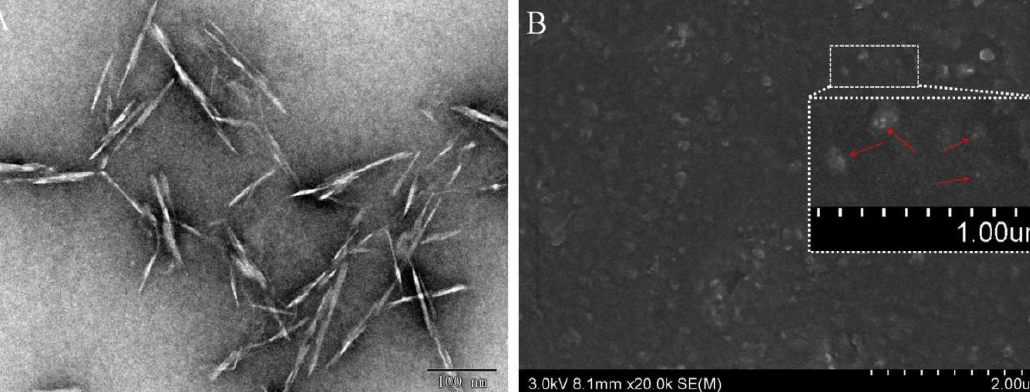
Polymers 2022 , 14 , x FOR PEER REVIEW Figure 3. The XPS spectrum of CNCs-based PUs ( A ) and 3d core level in Ag/TA-CNC-PU ( B ).